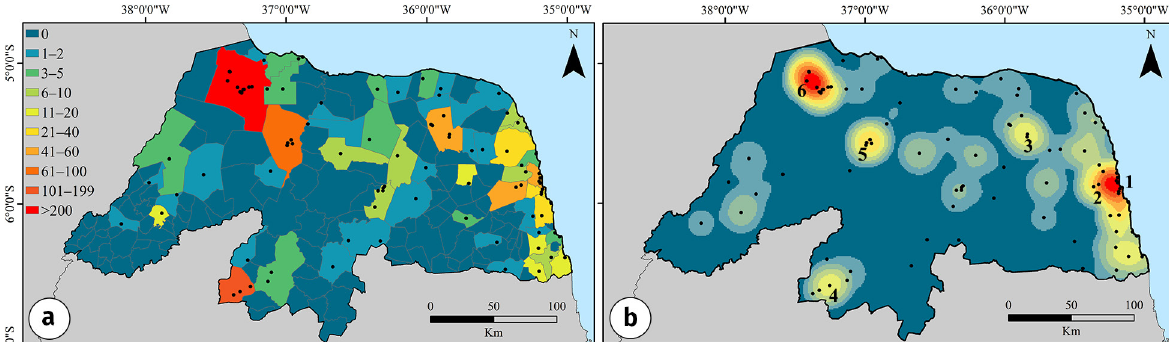
Figure 6. Frequency of snake records in municipalities of Rio Grande do Norte (RN) state, Brazil ( a ) and Kernel density map showing the concentration of snake richness over RN ( b ). Warmer colors show higher richness and frequency, black dots represent snake records. We highlight the municipalities of Natal (1), Macaíba (2), João Câmara (3), Serra Negra do Norte (4), Assú (5), and Mossoró